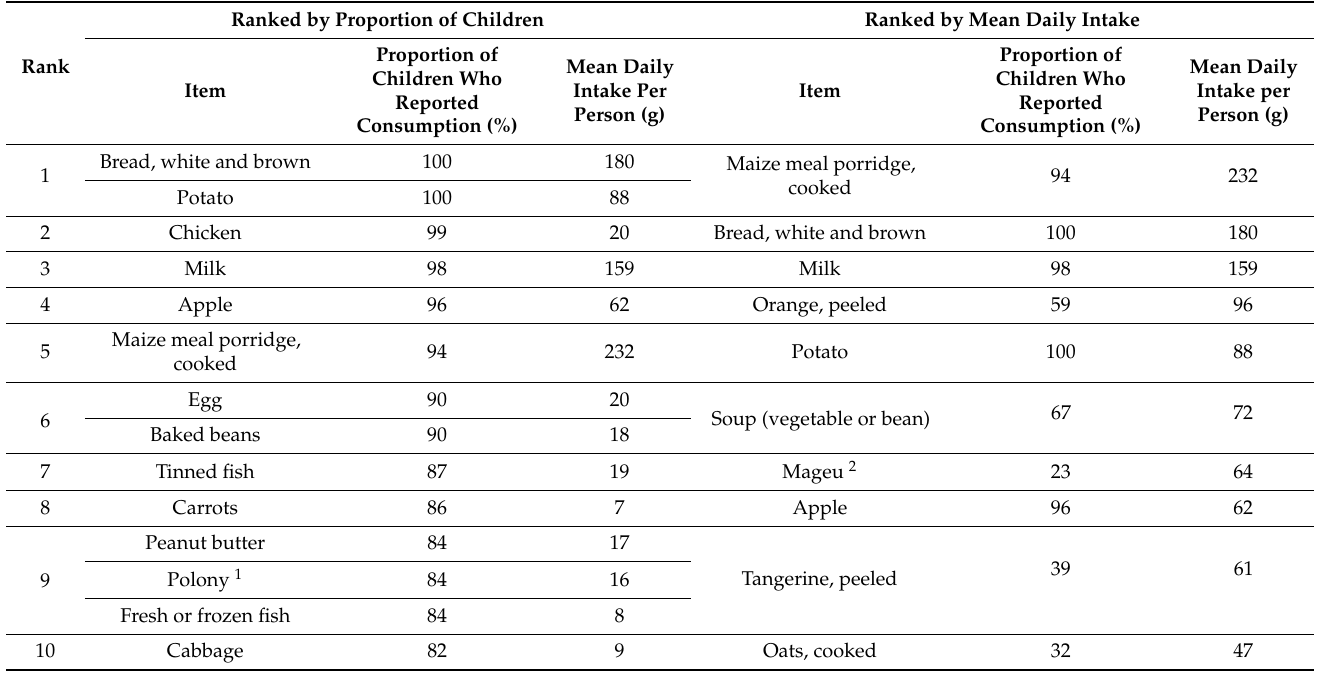
Table A2. Most eaten food items from the abbreviated quantified food frequency questionnaire by all children ( n =